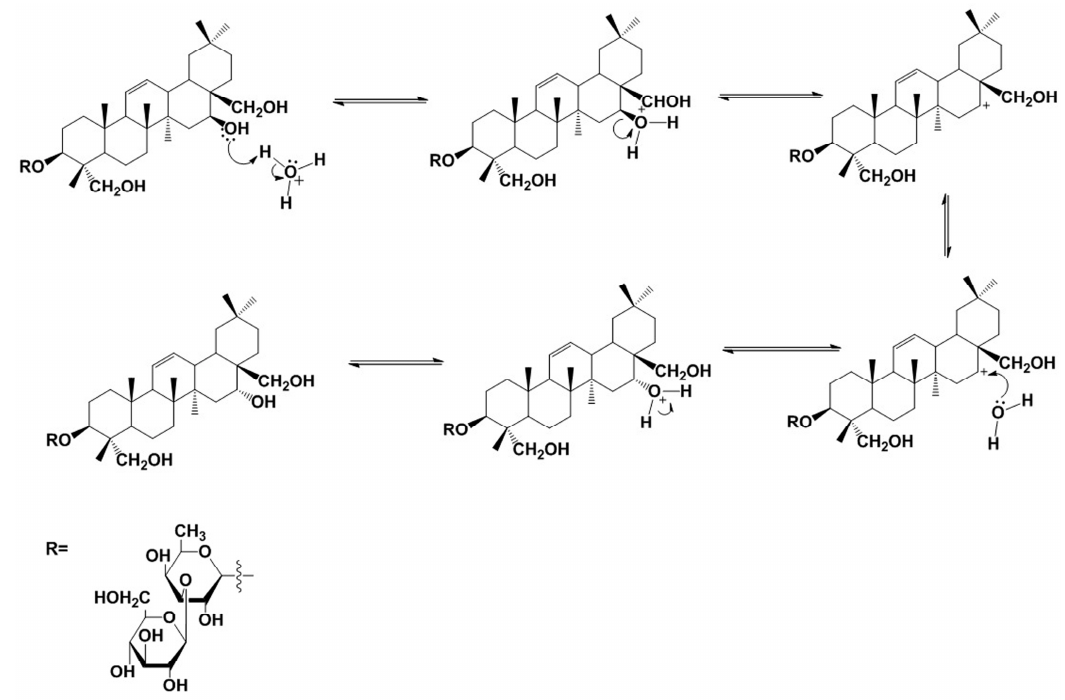
Figure 5. Proposed structural transformation pathway of saikosaponin B2.